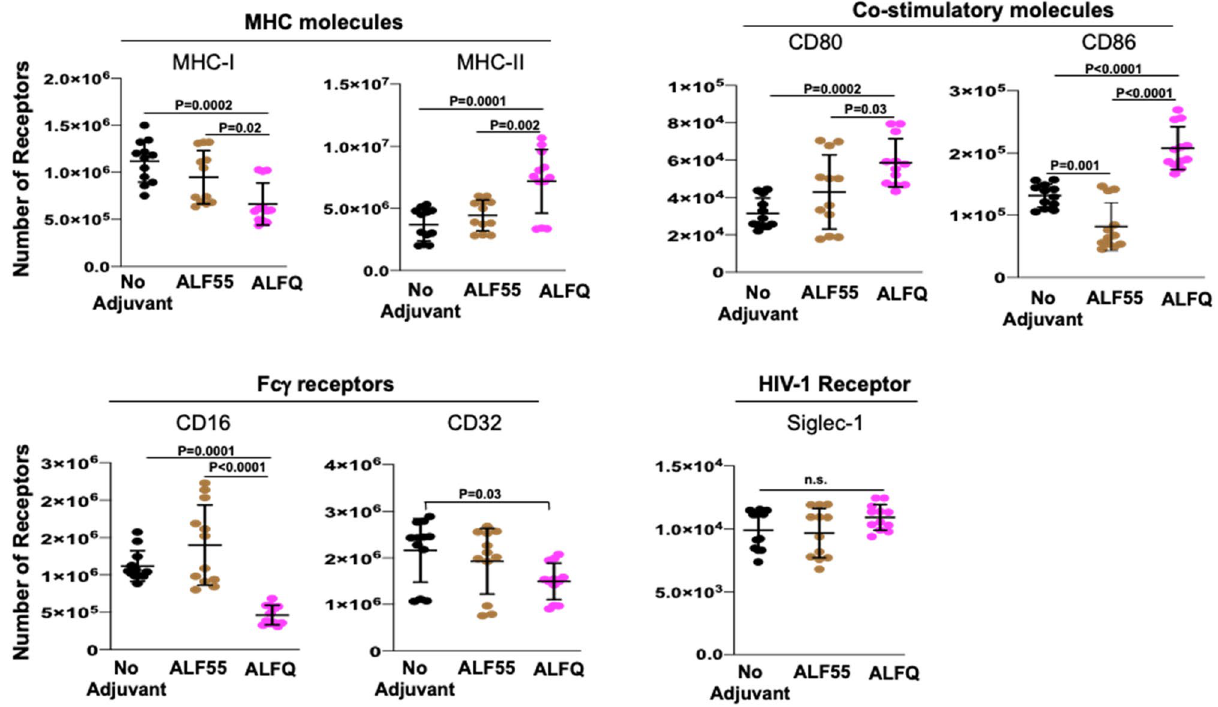
Figure 5. Receptor numbers on MDM are differentially affected by ALFQ. Primary human monocytes were differentiated into MDM following culture with M-CSF media. At day 4 post-culture, the cells were treated with ALF55 or ALFQ for 24 h. Untreated MDM (no adjuvant) cultures served as controls. Cells were harvested, stained, and the number of MHC-I, MHC-II, CD80, CD86, CD16, CD32 and Siglec-1 receptors was quantified by flow cytometry. Scatter dot plots show the number of the indicated cell receptors on the gated CD14 + MDM that were not treated with any adjuvant (black circles) or were treated with ALF55 (brown circles) or ALFQ (magenta circles) for triplicate wells for the four donors shown in Fig. 4. Data are representative of two independent experiments. P values indicate statistical differences by One-way